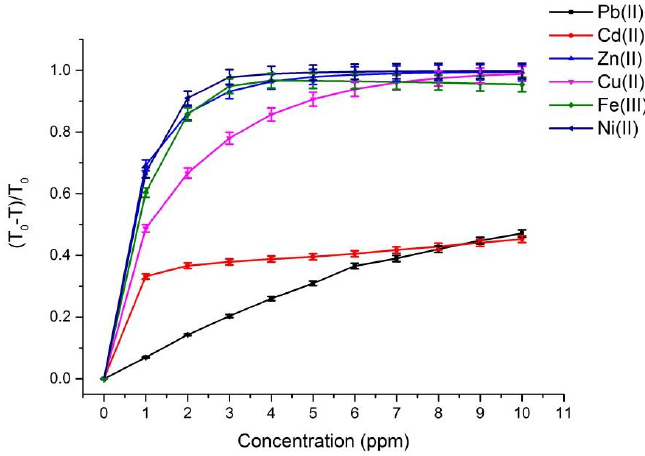
Figure 2. The response curves obtained from the transmittance spectra at 525 nm which were achieved with the Ultraviolet-visible (UV-VIS) stectrophotometer for different metallic ions at different concentrations. The measurements were repeated ten times and the fluctuations of each experimental point were about 0.01%. The error bars were calculated considering the transmittance error of the spectrometer 2.5%.